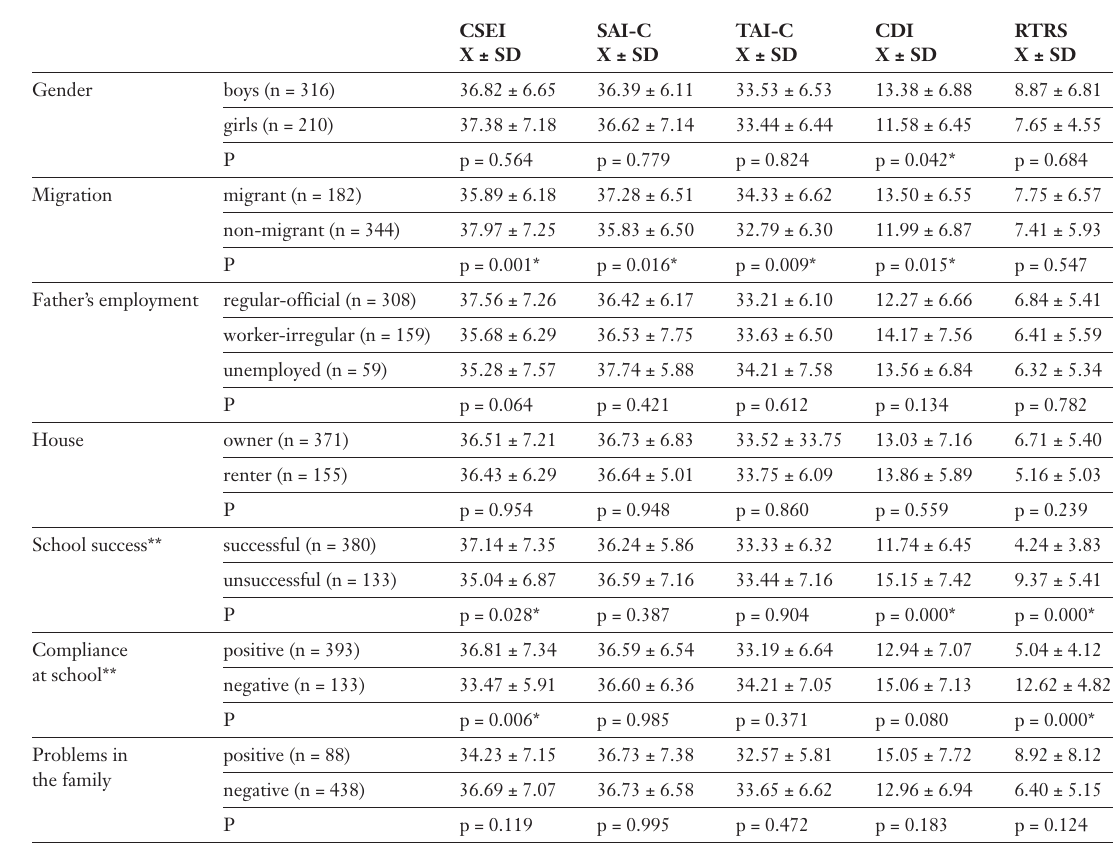
Sociodemographic variables between migrant (n = 182) and non-migrant (n = 344) children.